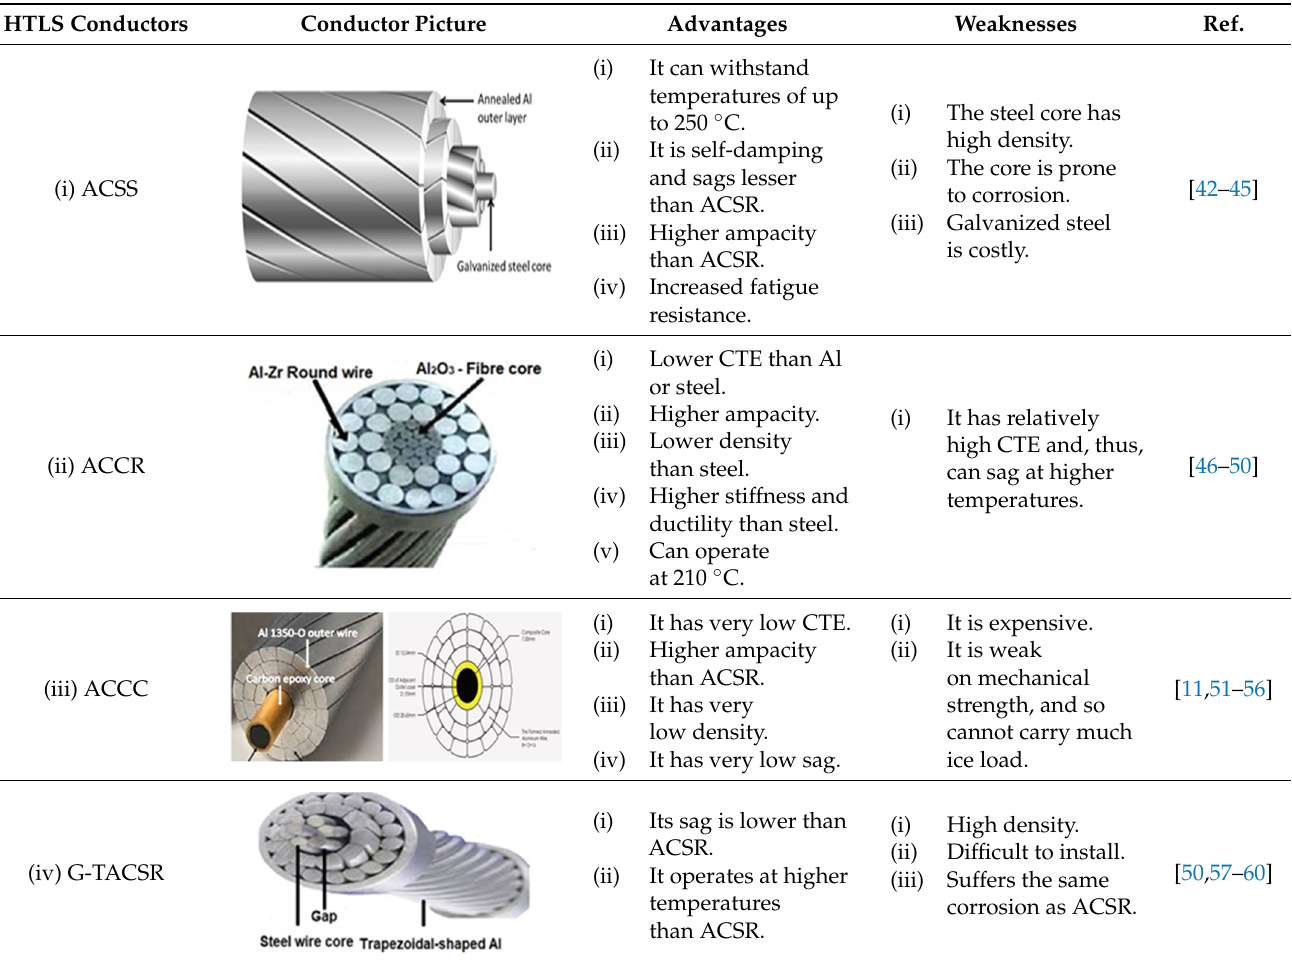
Table 1. HTLS conductors and their properties.